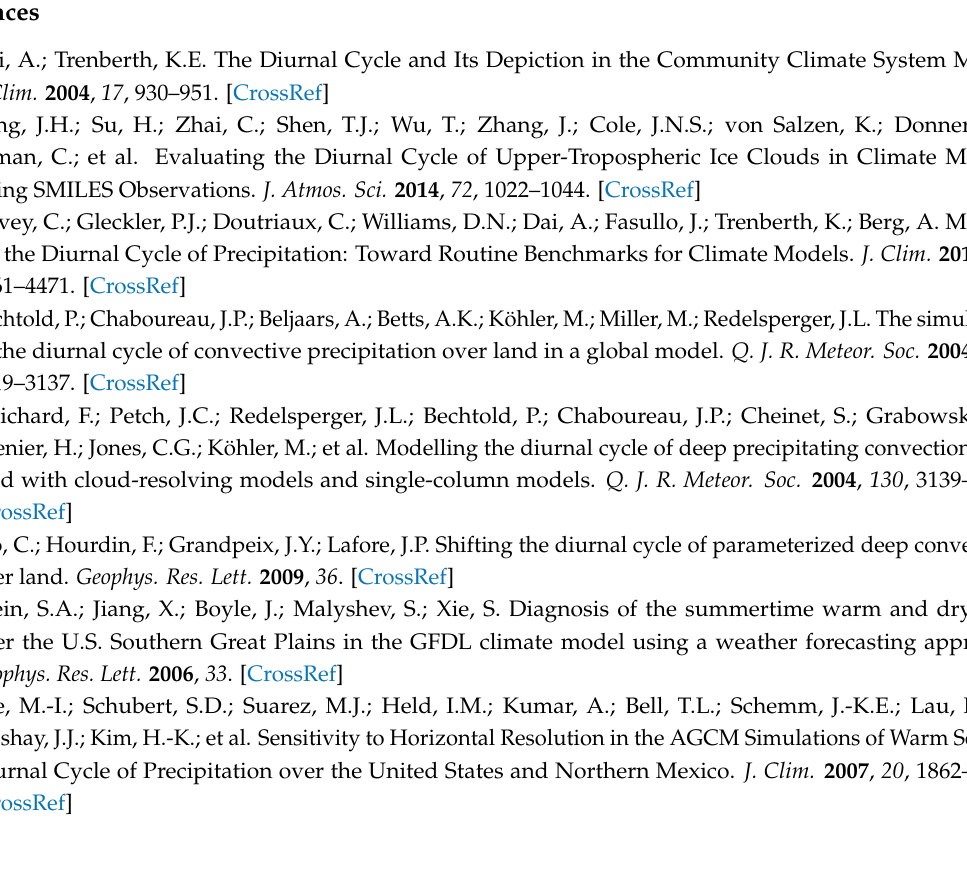
Figure S1: The difference of five-year mean precipitation rates (unit: mm · day − 1 ) in June–July–August (JJA) months between CAM5 and SPCAM5 (CAM5 minus SPCAM5) over continental East